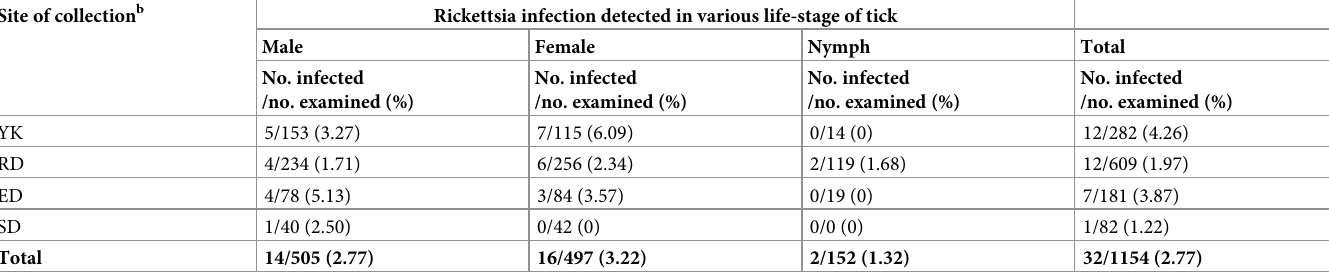
(ON093130). The GenBank accession numbers for the PCR-amplified ompB gene of 8 Table 1. Molecular detection of Rickettsia infection a in Rhipicephalus sanguineus ticks of Taiwan. Site of collection